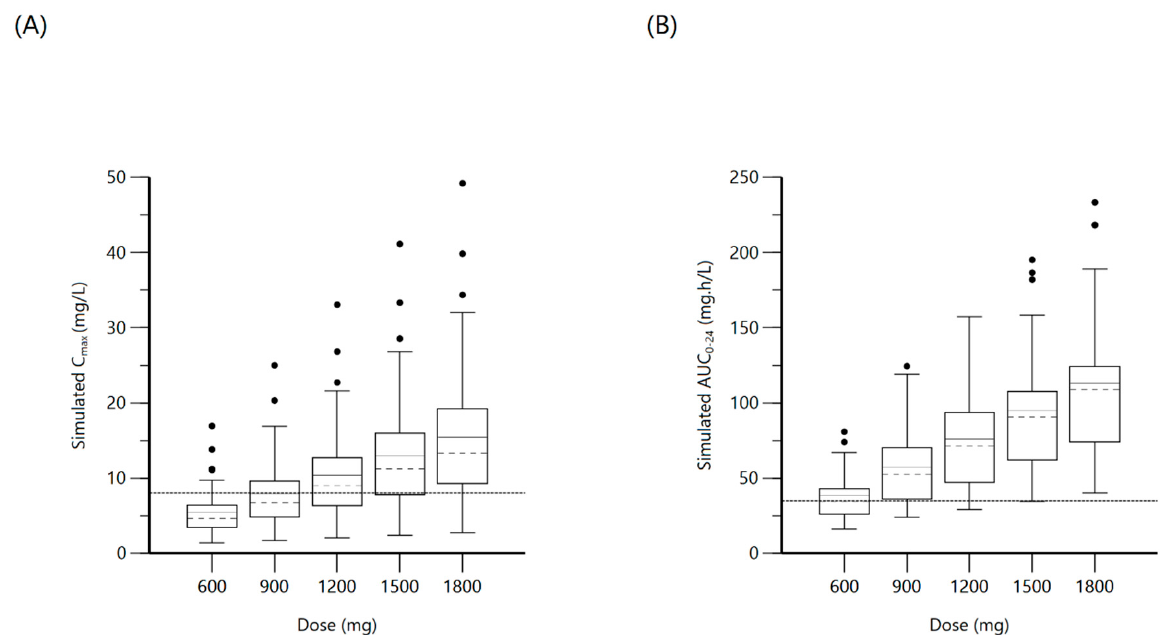
Figure 2. Plot ( A ) represents simulated rifampin C max at various doses with the dashed line indicating the minimum threshold of 8 mg/L. Plot ( B ) represents simulated rifampin AUC 0–24 at various doses with the dashed line indicating the minimum threshold of 35.4 mg · h/L. Table 3. Pharmacokinetic estimates for the final models of rifampin, isoniazid, pyrazinamide, and Table 4. Summary of pharmacokinetic measurements and percentage attaining target at various ethambutol. Ka, absorption rate constant; V, volume of distribution in the central compartment; V2, volume of distribution of the peripheral compartment; Cl, systemic clearance; Cl2,